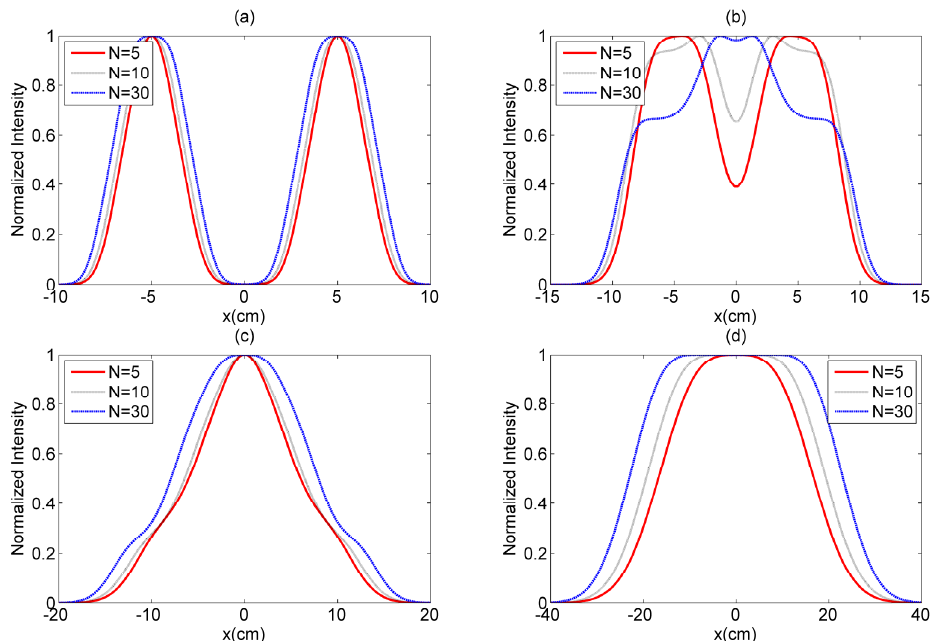
Figure 5. Cross sections ( y = 0) of the normalized intensity of a RPLMGSMV beam array with Q = 4 in free space for the different N . ( a ) z = 50m, ( b ) z = 200m, ( c ) z = 400m, ( d ) z = .